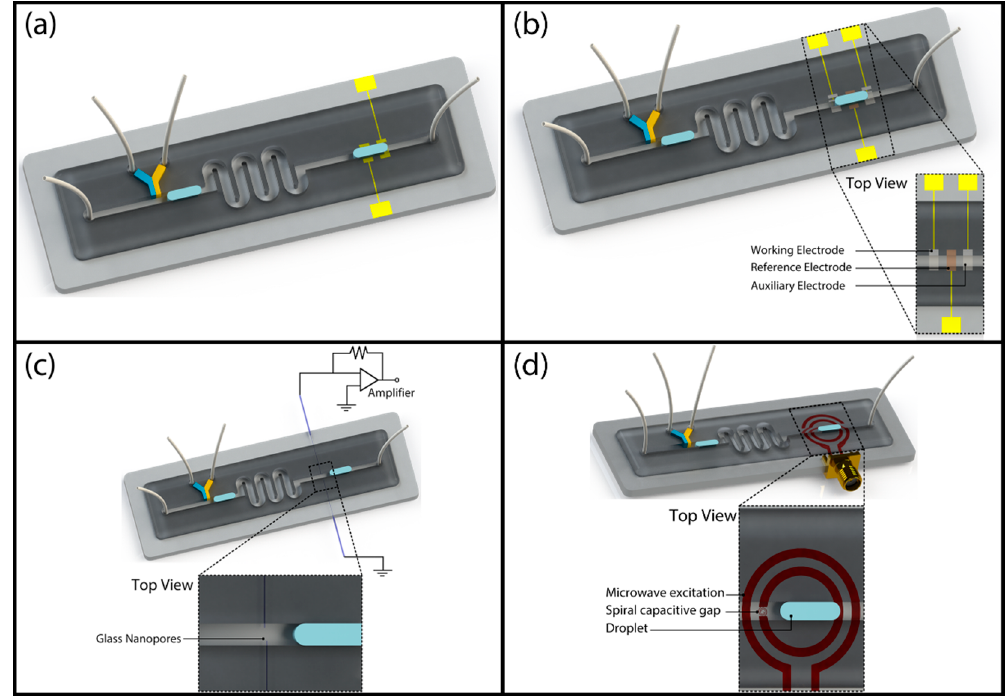
Figure 5 . Schematic illustration of label-free electrical detection techniques: ( a ) impedimetric sensing; ( b ) electrochemical sensing; ( c ) resistive pulse sensing; ( d ) microwave sensing.